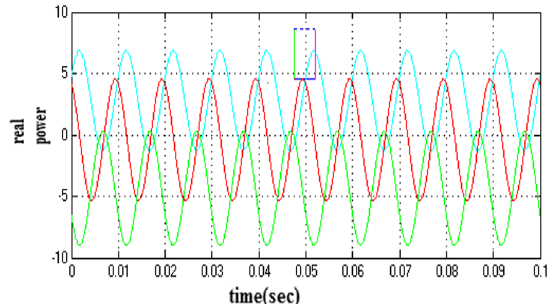
Fig. 8 Real power flow between buses 5 and 6 with SPWM switching of TCSC for IEEE 9 bus system